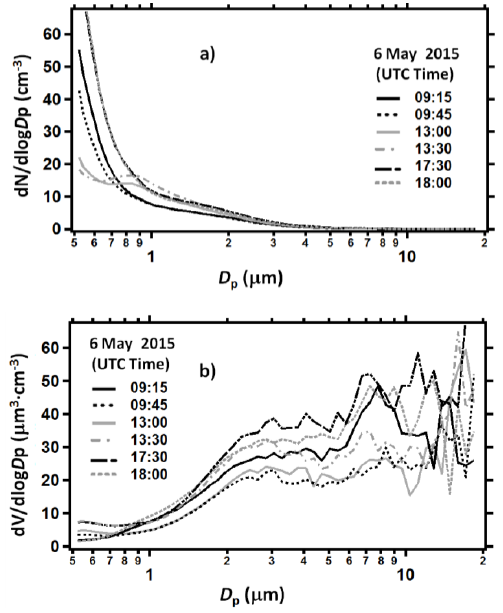
Figure 9. ( a ) Number ( N ) and ( b ) volume ( V ) particle concentrations versus the particle diameter ( D p )